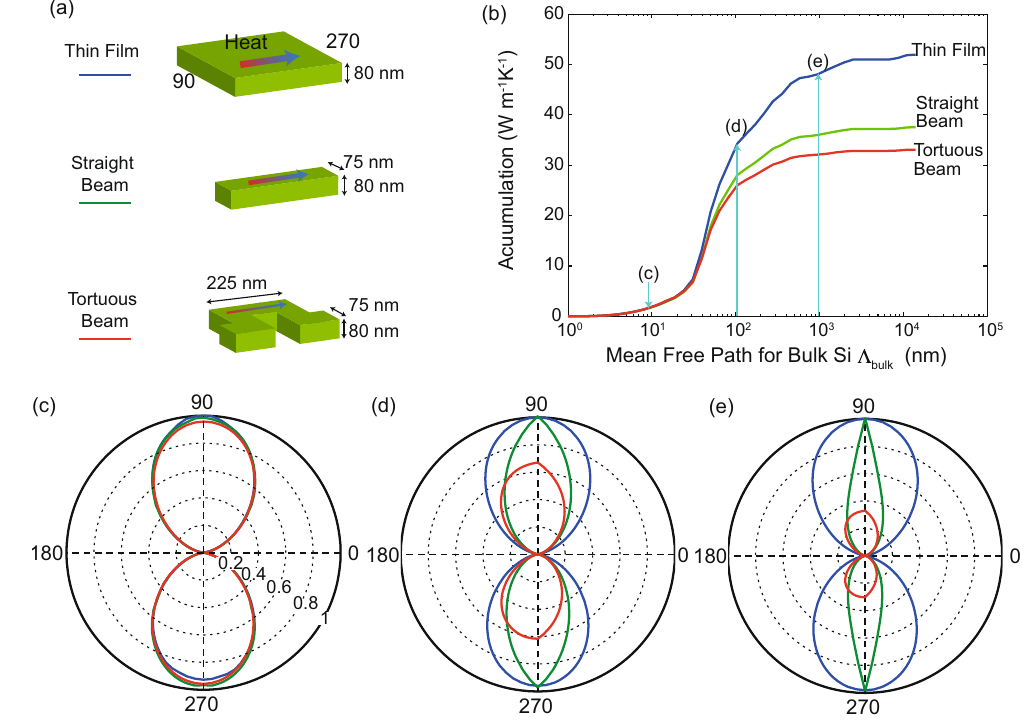
Figure 4. ( a ) Schematics for simulations, which includes a thin film, a straight beam, and a tortuous beam. ( b ) Thermal conductivity accumulation with bulk MFP Λ bulk . The blue arrow indicates the MFPs, where a direction suppression function is shown at marked figures ( c , d ). Direction suppression function for ( c ) Λ bulk = ~9 nm, ( d ) Λ = ~100 nm, and ( e ) Λ = ~900 nm. Heat flows from φ = 90 to φ = 270. These suppression functions are bulk bulk normalized with the value of a thin film, and the relative magnitude is shared among ( c – e